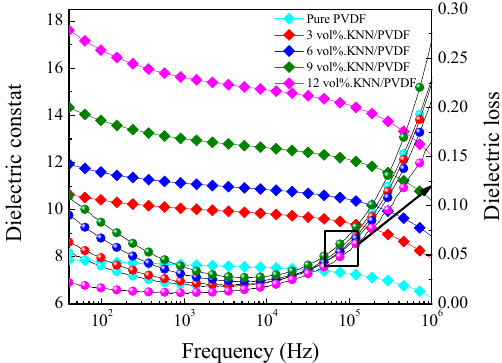
Figure 4. Dielectric constant and dielectric loss on frequency of pure PVDF and KNN/PVDF composite films.